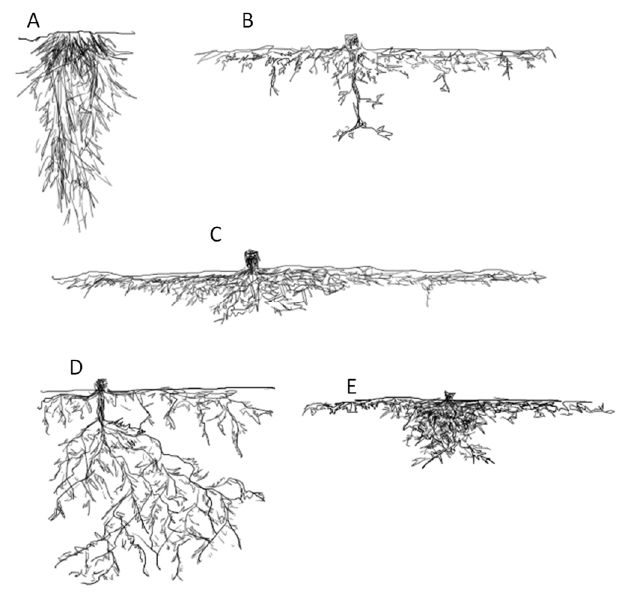
Figure 1. Different root systems development. ( A ) Tuft and deep root systems, ( B ) taproot root system, ( C ) superficial root system, ( D ) taproot and horizontal lateral roots, ( E ) heart-shaped root architecture. Redrawn by the authors from Ghestem et al. [5].